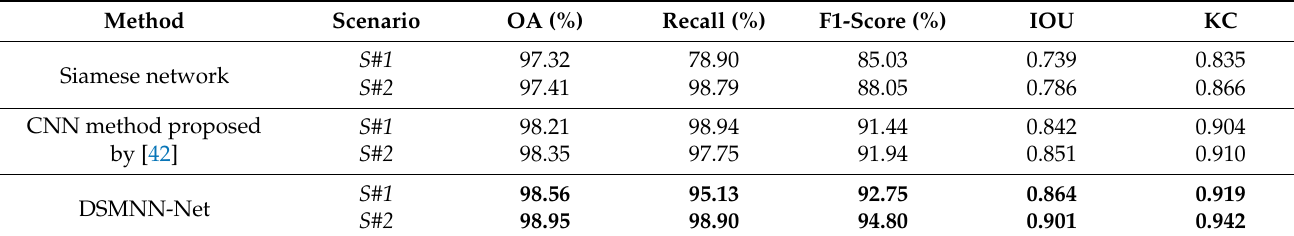
Table 5. Accuracy assessment for the burned area mapping for the second study area. S#1, pre/post-event Sentinel-2 imagery; S#2, pre-event Sentinel-2 imagery and post-event PRISMA